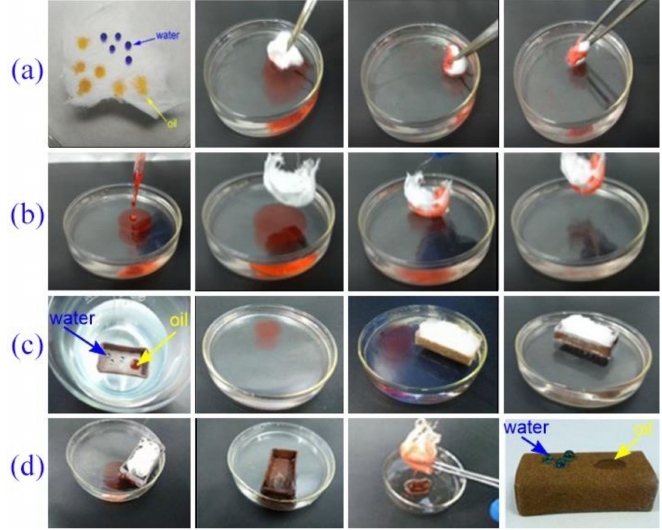
Figure 8. Oil absorption and collection using the as-spun PS fibers ( a ), the fibers embedded with a string bag ( b ), the superhydrophobic mini-boat ( c ), and the mini-boat loaded with the PS fibers ( d ),